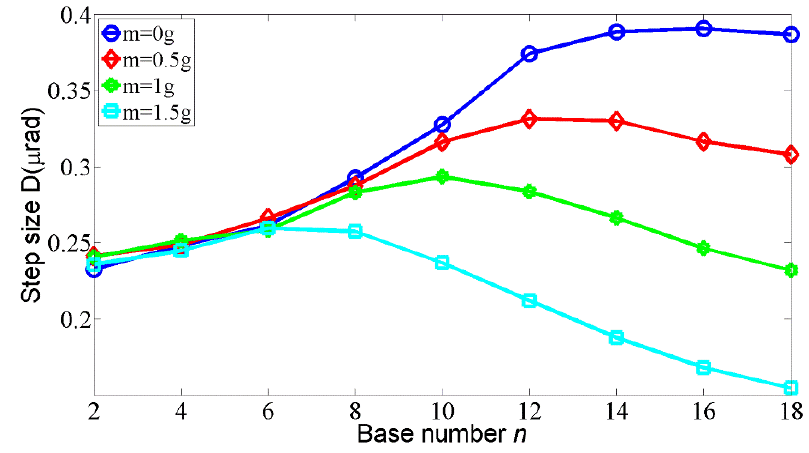
Figure 10. Step size D vs the base number n.